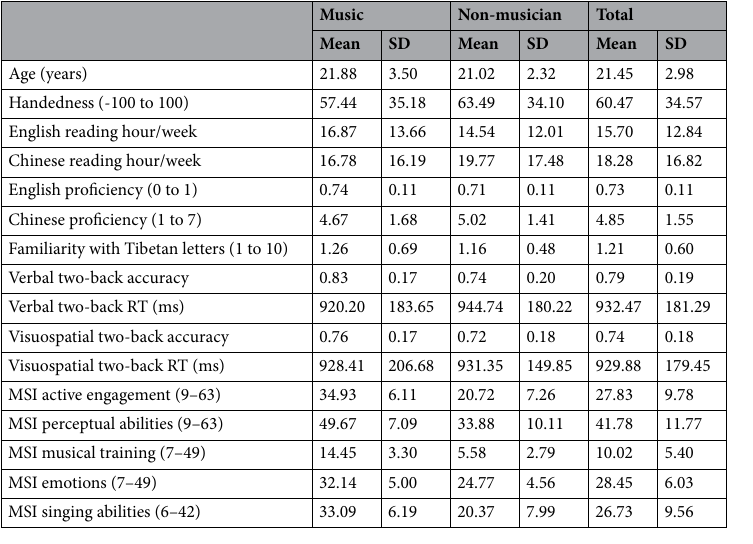
Table 1. Descriptive statistics of the